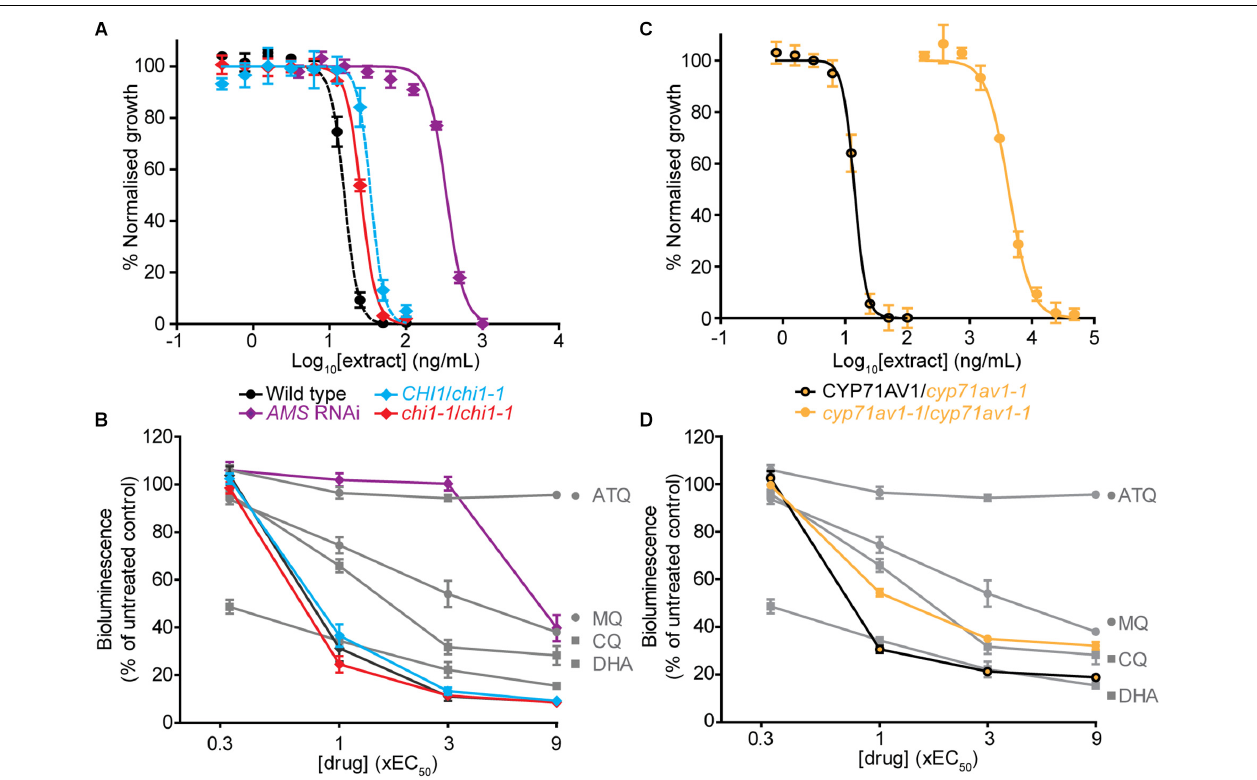
FIGURE 3 | Comparison of in vitro antiplasmodial activity of leaf extracts from Artemisia annua wild type, mutant and antisense lines with altered flavonoid and artemisinin content. (A,C) Log concentration-normalized response curves of Plasmodium falciparum parasites after 48 h of treatment with extracts used to determine the EC 50 (50% effective concentration of extract needed to inhibit growth of the P. falciparum parasites) of the indicated extracts. (B,D) Bioluminescent Relative Rate of Kill (BRRoK) assays to determine the initial (6 h) cytocidal action, compared to an untreated control after exposure to extracts of wild type, heterozygous and homozygous chi1-1 , and the AMS silenced line (B) or heterozygous and homozygous cyp71av1-1 (D) at multiples of the EC 50 alongside dihydroartemisinin (DHA) > chloroquine (CQ) > mefloquine (MQ) > atovaquone (ATQ) benchmark controls. Error bars represent standard deviations from the means of three biological